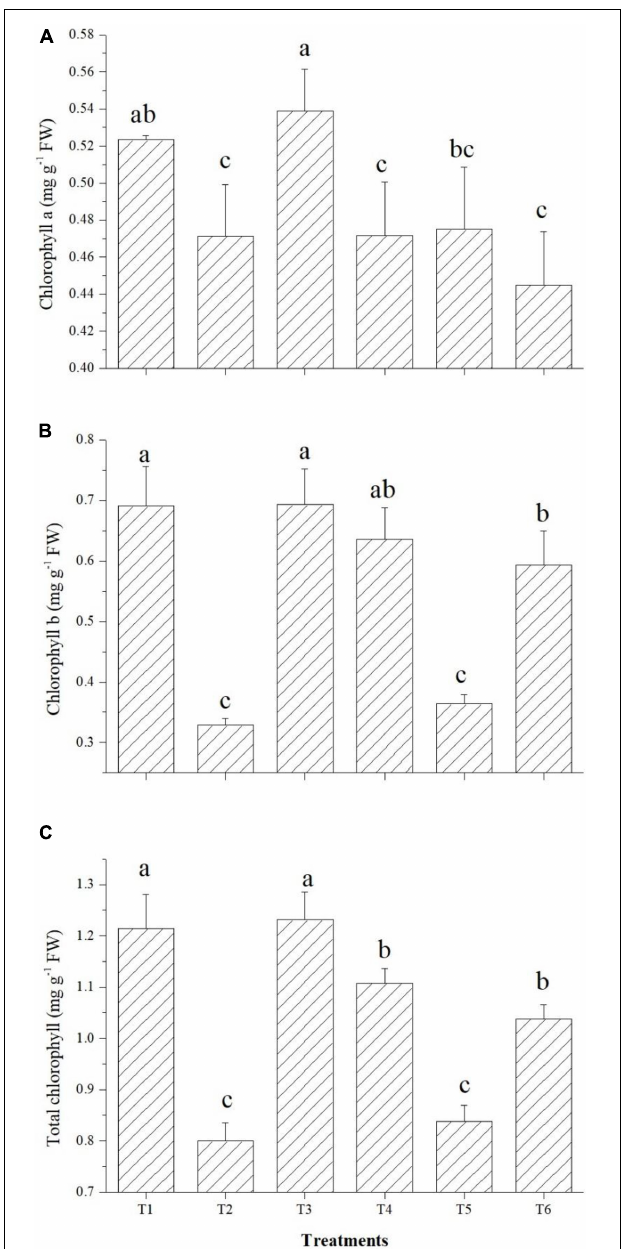
FIGURE 7 | Effect of bacterial endophytes on chlorophyll content under elevated salinity (150 mM NaCl). (A) Chlorophyll a , (B) chlorophyll b , and (C) total chlorophyll. T1, absolute control; T2, saline control; T3, BTL5; T4, GTR8; T5, GTR11; and T6,